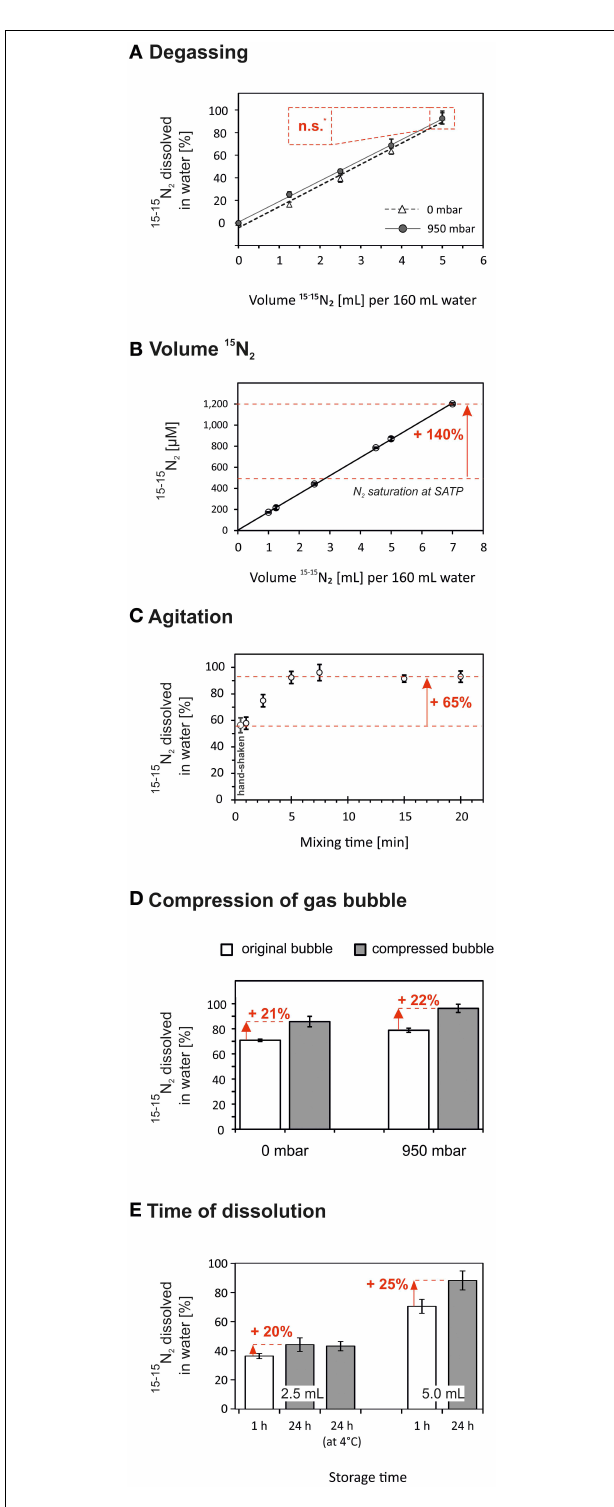
FIGURE 3 | The dissolution of 15 − 15 N 2 in water could be accelerated by applying optional methodological steps during the preparation of 15 − 15 N 2 -enriched water. Red numbers indicate the relative increase of the amount of 15 − 15 N 2 gas which dissolved in the water after the optional